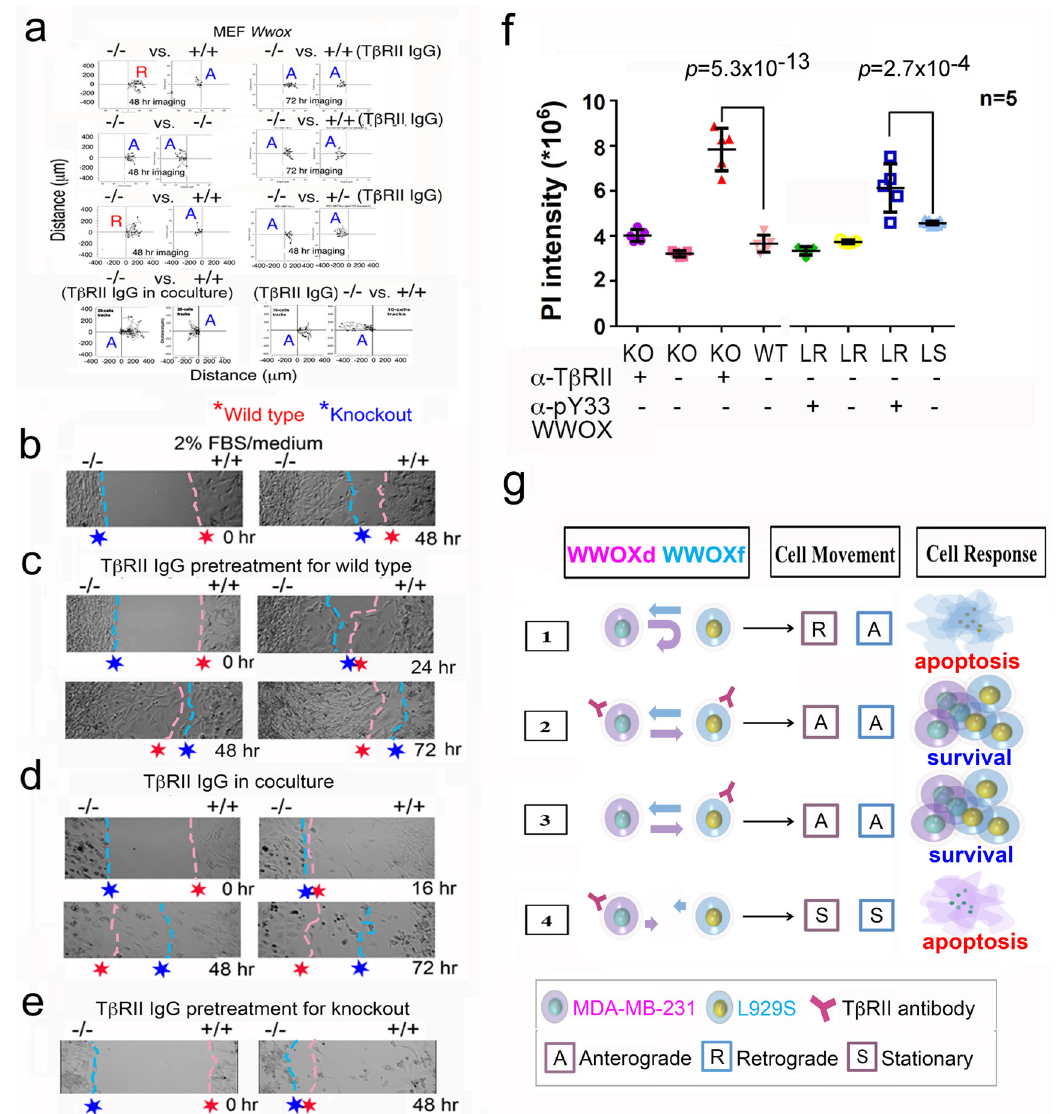
Fig. 3 T β RII controls cell-to-cell migration. a , b Migration of MEF Wwox -/- versus Wwox + / + or Wwox -/- cells (randomly tracking 10 cells; in duplicates). The knockout cells underwent retrograde migration upon encountering the wild type cells. c Pretreatment of wild type cells with T β RII IgG (2 μ g/ml) for 24 hr allows both cells to merge. d MEF wild type and Wwox knockout cells were co-treated with T β RII IgG during cell migration. Both cells merged and the wild type cell migration was accelerated. e When knockout Wwox cells were pretreated with T β RII IgG, the cell migration was retarded. f MEF Wwox knockout cells were pretreated with T β RII IgG (2 μ g/ml) for 24 hr, followed by washing and processing the migration assay versus knockout cells or wild type MEF cells for 24 hr. Similarly, L929R cells were pretreated with pY33-WWOX antiserum (1:100 dilution) for 24 hr, and then subjected to the migration assay versus L929R or L929S cells. The extent of cell death was measured by PI uptake. g A summarized schematic graph illustrates the role of T β RII in regulating the migration of WWOXd versus WWOXf